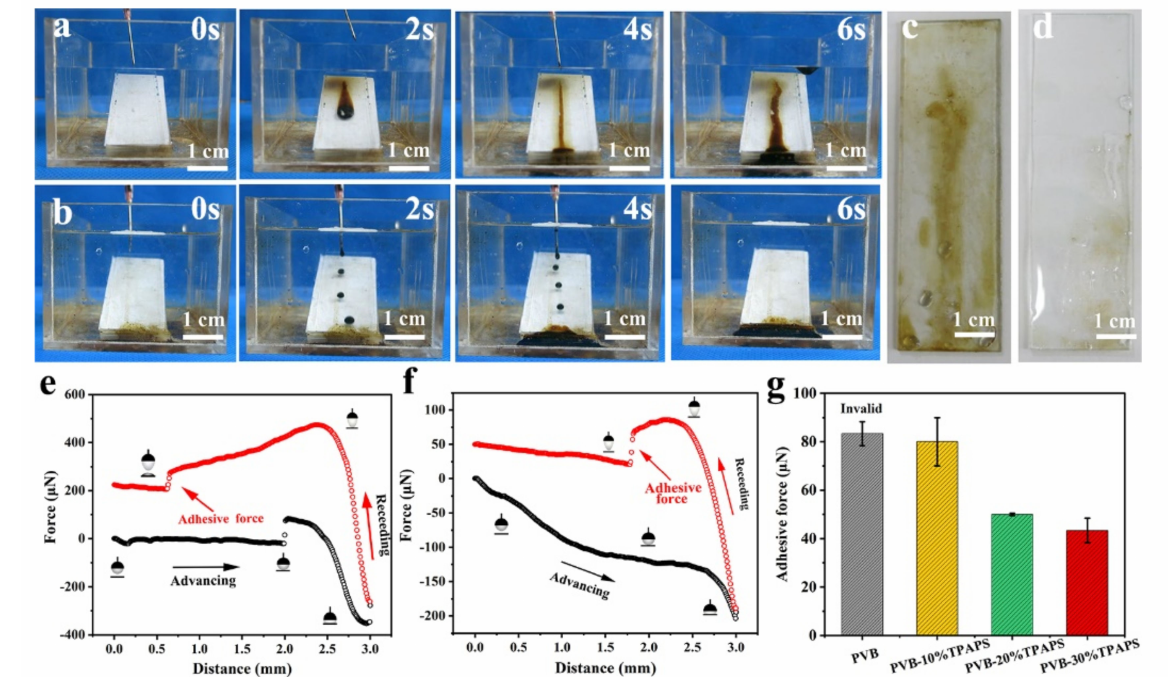
Figure 7. The anti-contamination properties of the PVB-X% TPAPS coatings. Selected snapshots show the crude oil impinging on the coated surfaces for the PVB coating ( a ) and the PVB-20% TPAPS coating ( b ) at various times; the optical photographs of the PVB ( c ) and PVB-20% TPAPS ( d ) were taken from the water tank when the tests had finished; the typical underwater adhesive curves of the PVB coating ( e ) and the PVB-20% TPAPS coating; ( f ) the statistical adhesive forces of n-hexane on the coatings ( g ), the insets illustrate the oil-drop state at different time